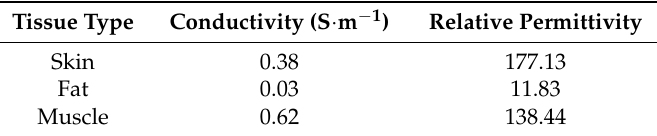
Table 6. Human Tissue Electrical Specification (13.56 MHz).